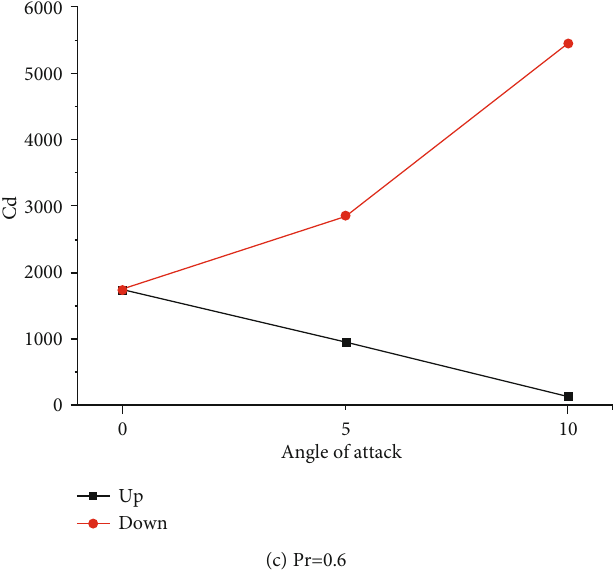
Figure 10: Resistance coe ffi cients of upper and lower walls at di ff erent pressure ratios and angles of attack.